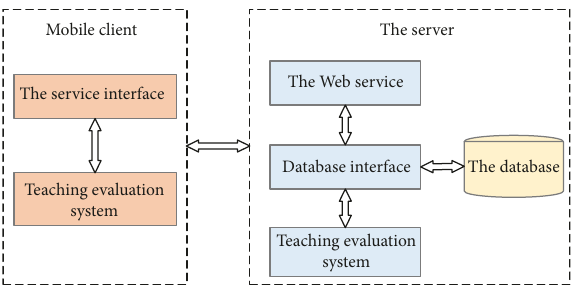
Figure 5: Architecture of teaching quality evaluation